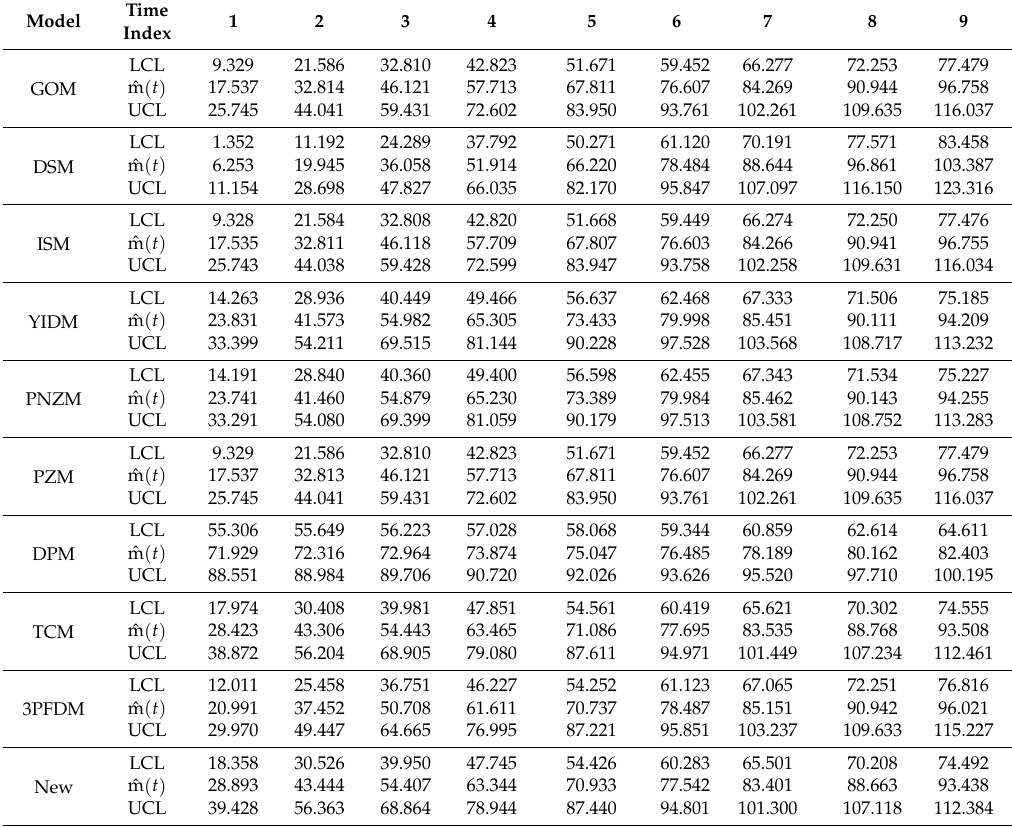
Table A1. 95% Confidence interval of all 10 models